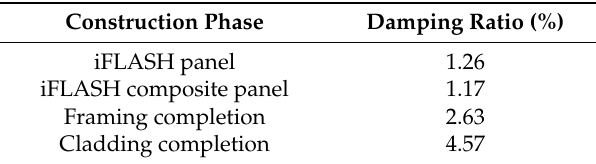
Table 5. Damping ratios of specimens [19].